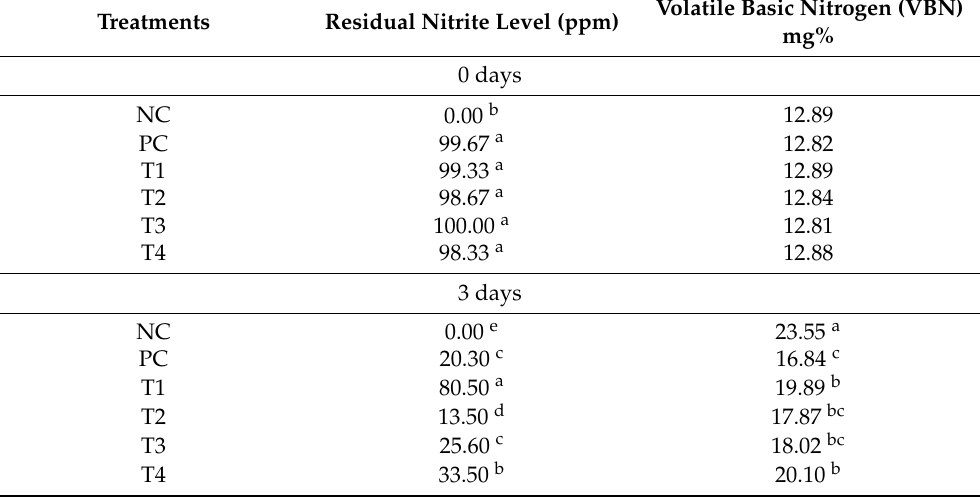
Table 6. Changes in residual nitrite level and volatile basic nitrogen of minced pork depending on treatment and storage